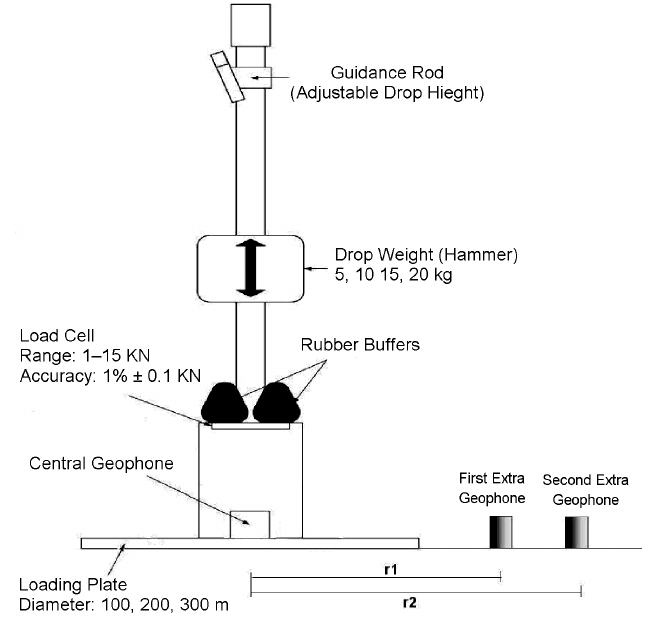
Fig. 1. Schematics of a Portable Falling Weight Deflectometer (Fleming et al. 2007)